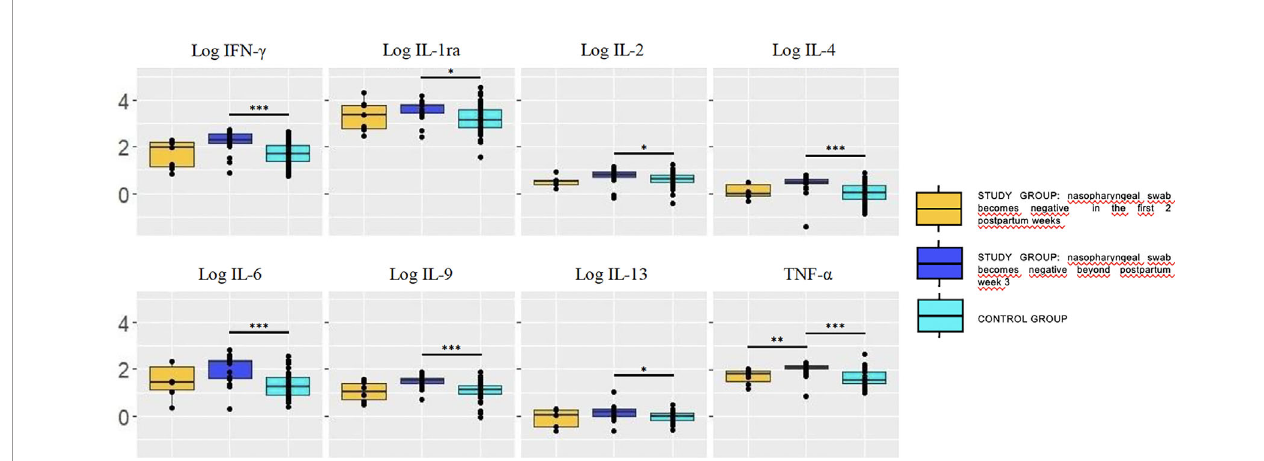
FIGURE 2 | Concentration (log) of cytokines in breastmilk of study group women according to the moment in which the nasopharyngeal test becomes negative (pooling samples obtained at weeks 1 and 5). Cytokine concentrations were signi fi cantly higher in breastmilk samples of mothers whose RT-PCR remained positive at postpartum week 3 (dark blue box) compared with the control group. Trends also pointed toward higher concentrations in the former compared with those who became negative sooner, within the fi rst 2 postpartum weeks (yellow box). The values are expressed as log 10 of the concentrations (ng/L). Statistical differences on pairwise post hoc comparisons between the study and control groups are indicated with an asterisk (*p < 0.05; **p ≤ 0.01; ***p ≤ 0.001, Wilcoxon rank test, Bonferroni post hoc test).